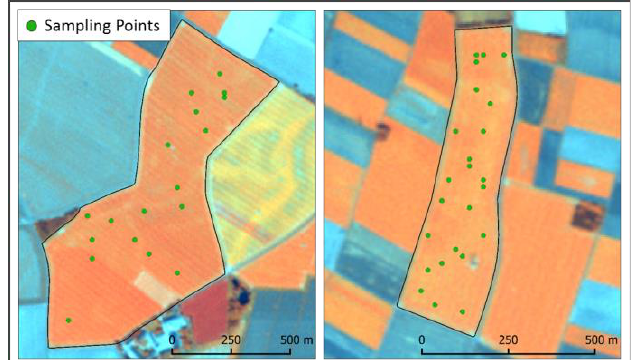
Figure 1: Sampling points for sugar beet yield (Background image: Rapid Eye image of Jul 19 th 2014, UTM33N, colour combination: 656nm, 710nm,